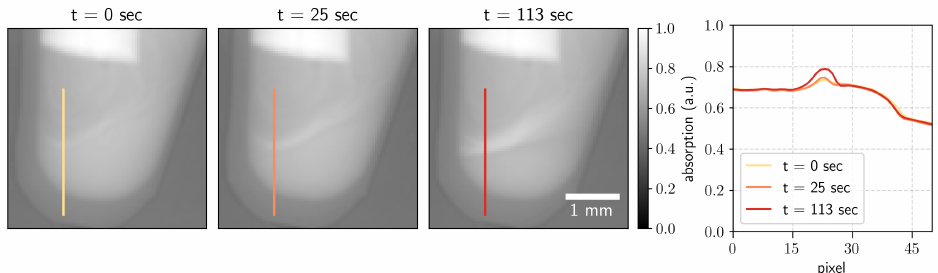
Figure 2. Absorption images for the measurement time t = 0, 25, and 113 s with the corresponding profiles along the indicated lines.